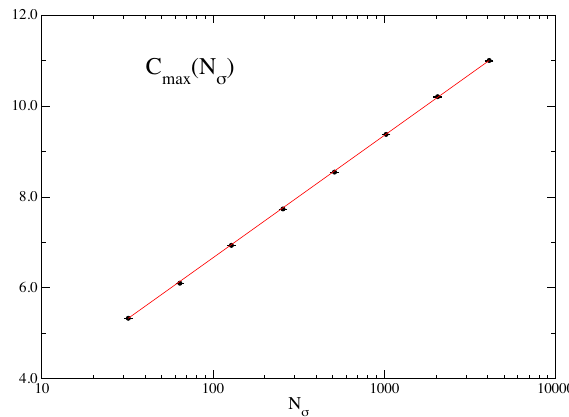
Figure 9 . Peak height of speci(cid:12)c heat C max ( N (cid:27) ) at N (cid:28) = 3 as a function of N (cid:27) . The horizontal axis is logarithmic. Solid line is to guide your